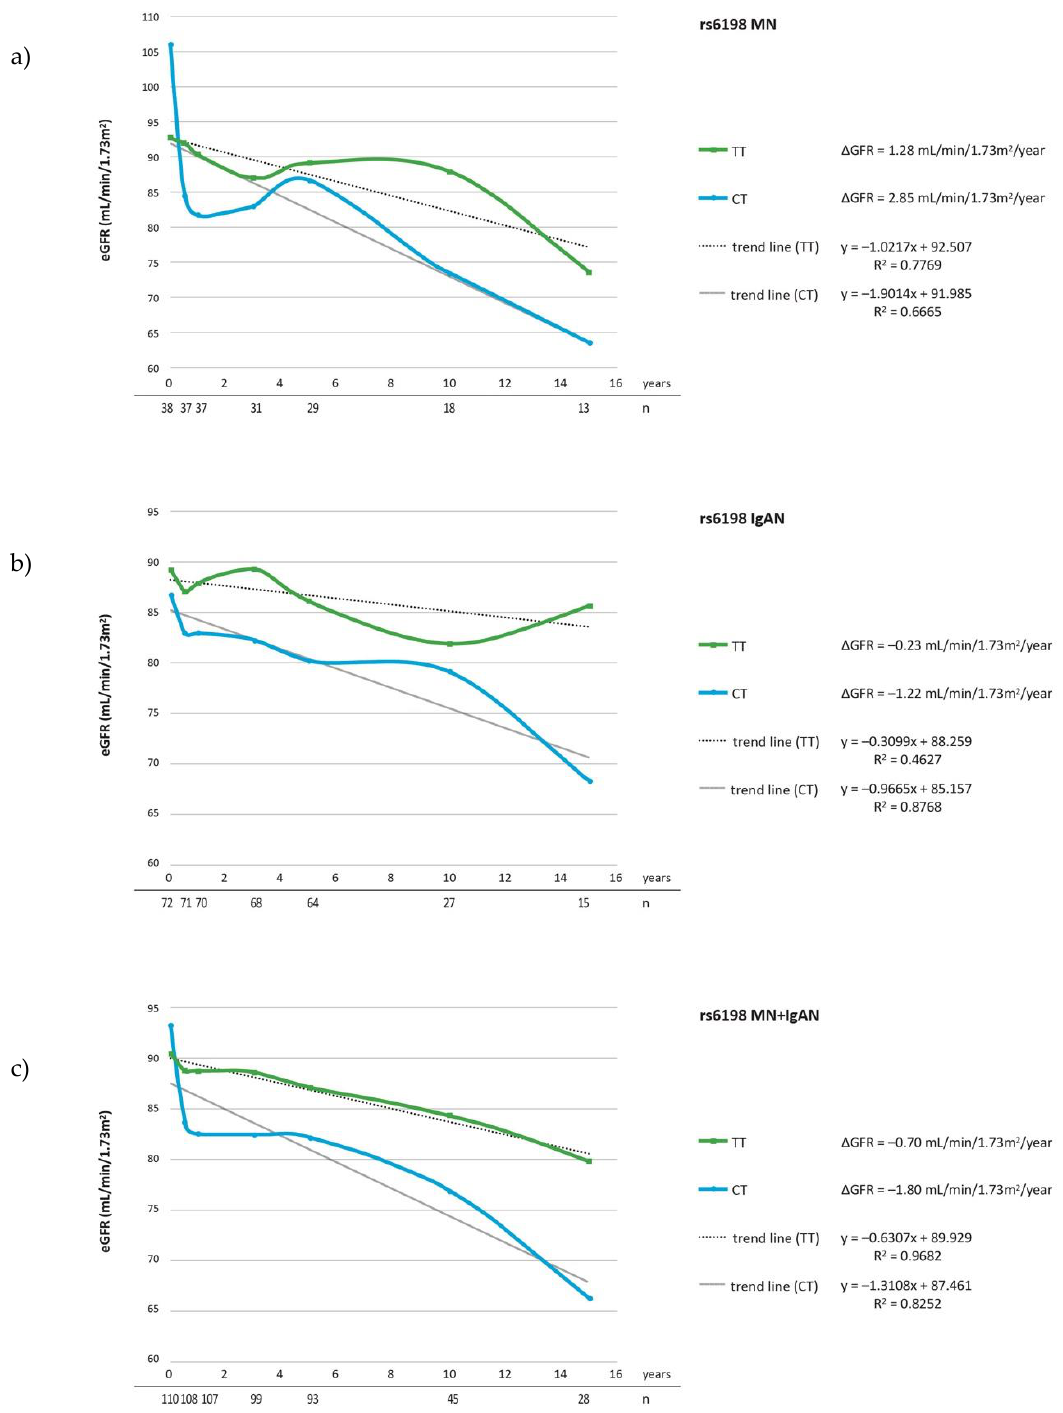
Figure 1. ∆ eGFR for rs6198 genotypes during follow-up period in ( a ) MN patients; ( b ) IgAN patients; ( c ) MN + IgAN patients. Number of patients are expressed as ( n ).